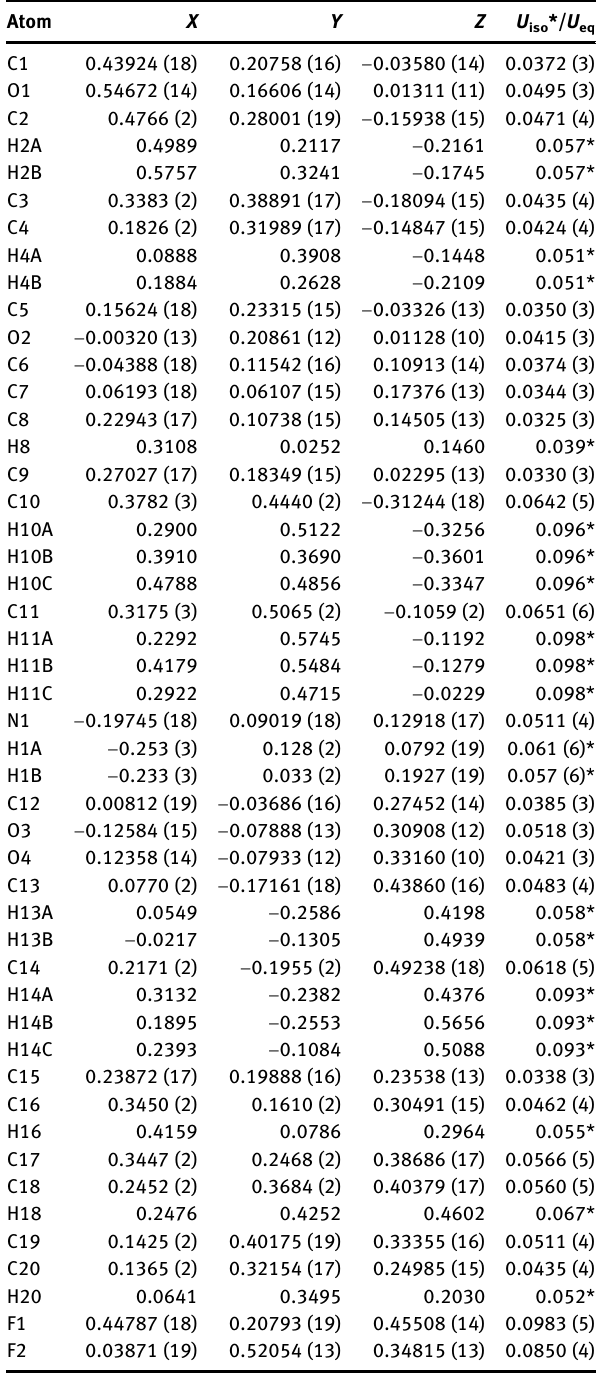
Table  : Fractional atomic coordinates and isotropic or equivalent isotropic displacement parameters (Å 